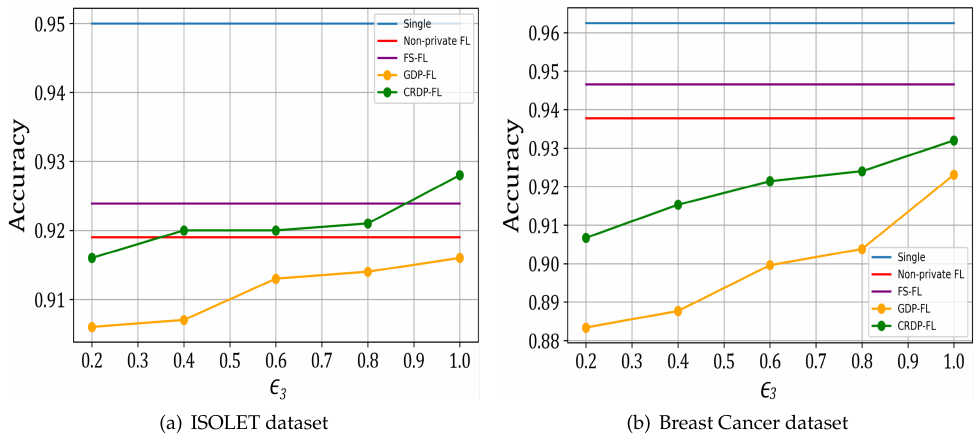
Figure 4. Accuracy comparison of algorithms under different privacy budgets on different datasets.